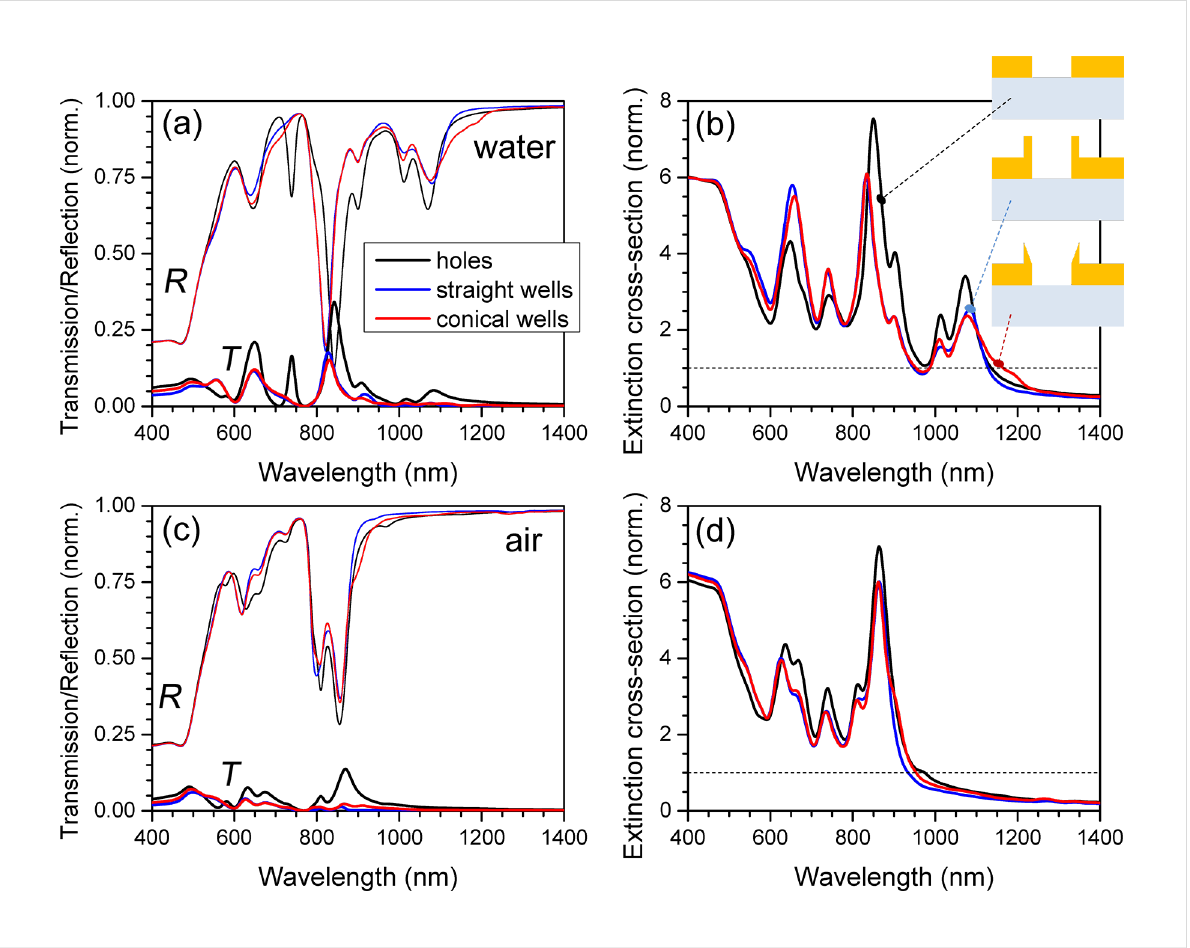
Figure 2: (a) Transmission T and reflectivity R coefficients for different geometries of the hole/well-array structures (see Figure 1 for geometry: hole diameter D = 200 nm, well height h = 100 nm, width of the well structure at the base w = 30 nm, and thickness of Au film 100 nm). Calculated for immersion in water with refractive index n w = 1.33. (b) Extinction cross-sections normalized to the geometrical cross section (dashed line). (c) and (d) are the same as (a) and (b), but for